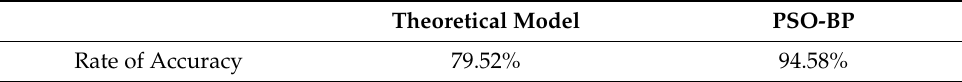
Figure 10. Comparison of PSO-BP with Theoretical Model for Failure Mode. Table 7. Rate of Accuracy of Failure